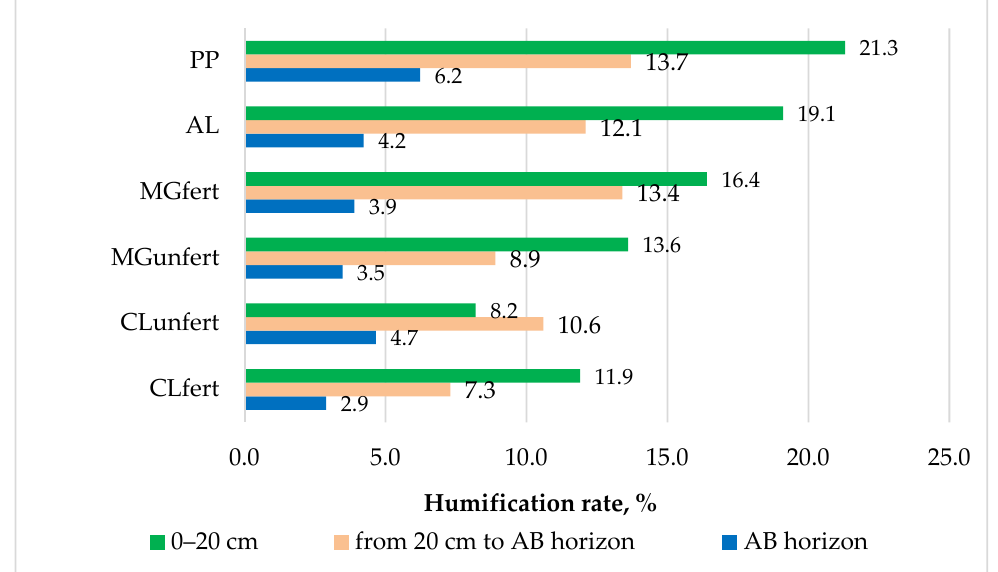
Figure 5. Humification rates in soils of different types of land use. Note. Abbreviations: CLfert: cropland fertilized; CLunfert: cropland unfertilized; AL: abandoned land; MGunfert: managed unfertilized grassland; MGfert: managed fertilized grassland; AL: abandoned land; PP: pine plantation.